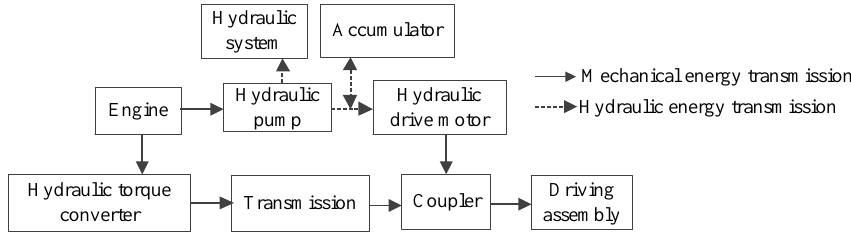
Figure 5. Typical configuration of parallel oil–hydraulic hybrid system [22,31].